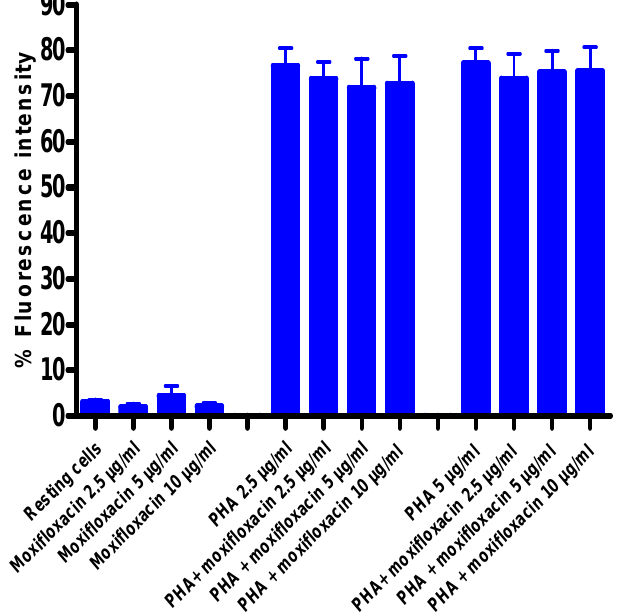
Figure3. Effect of moxifloxacin on CD25 expression by PHA-activated